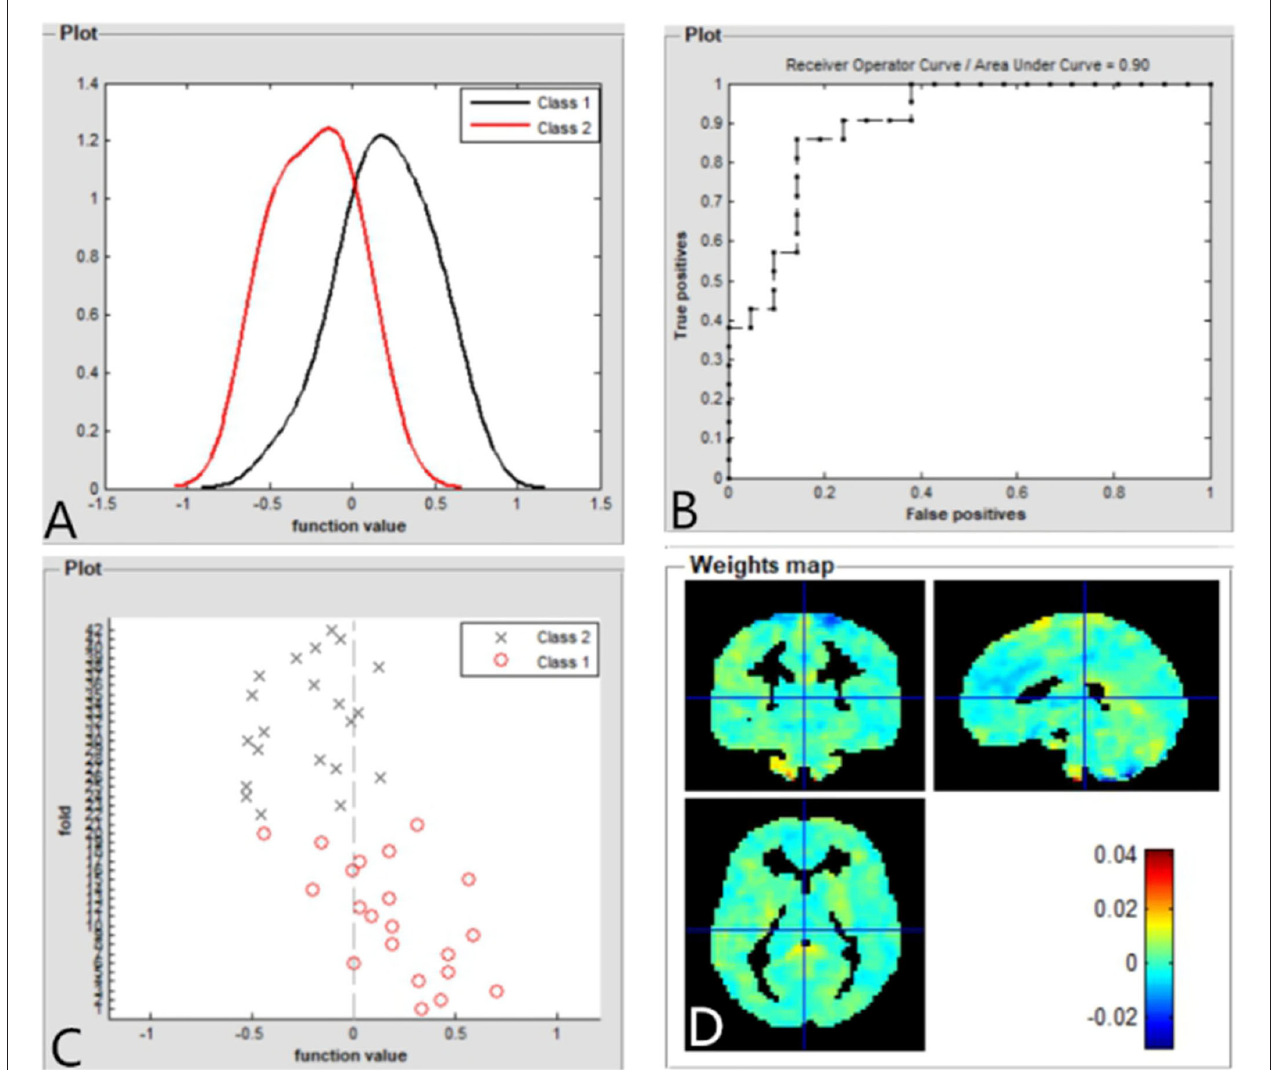
FIGURE 5 | Based on fALFF values, distribution of function values of the two groups (class 1: patient group; class 2: HC group) (A) ; the ROC curve of the classifier, and the AUC was 0.90 (B) ; function values of the two groups (class 1: patient group; class 2: HC group) (C) ; weight maps for SVM models (D) . fALFF, fractional amplitude of low-frequency fluctuation; ROC, receiver operator characteristic; AUC, areas under curve; CE, comitant exotropia; HC, healthy controls; SVM, support vector